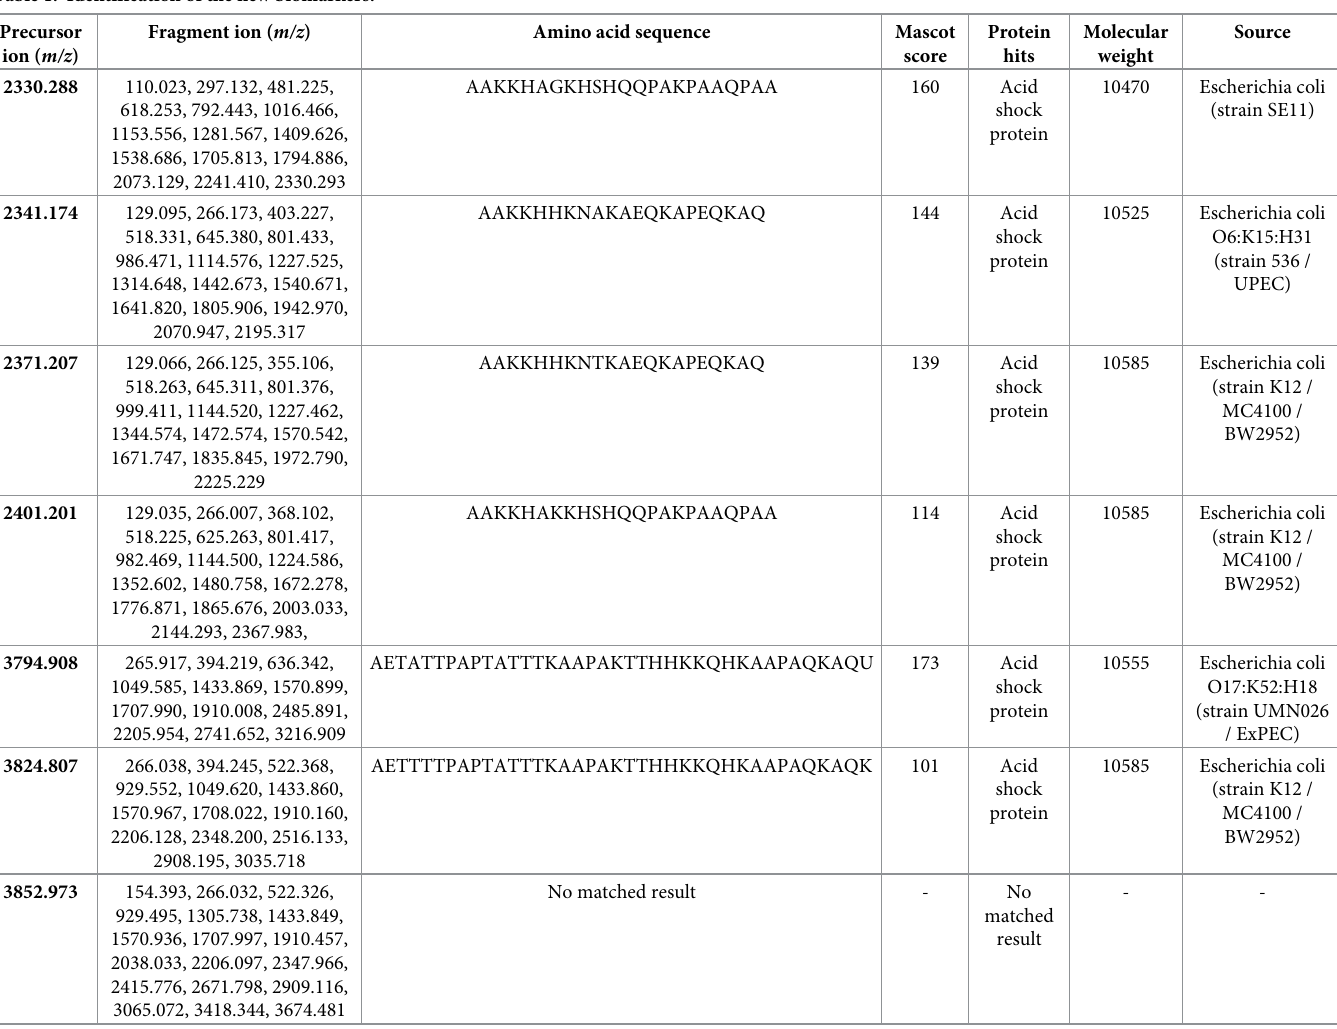
Table 1. Identification of the new